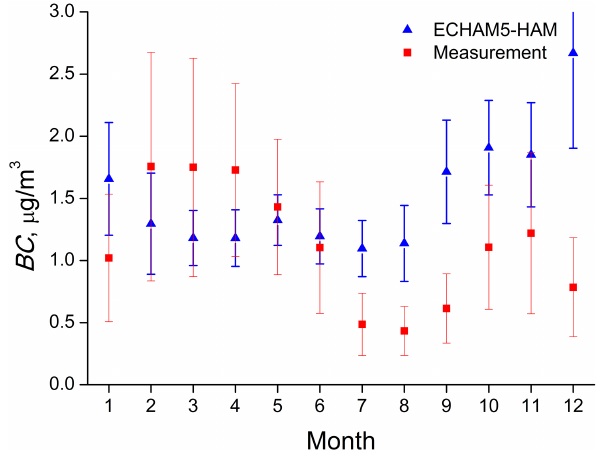
Figure 2. Surface BC concentration (in µgm − 3 ) in Mukteshwar measurements and in the MAIN_ACT simulation with GAINS emissions and aerosol cloud activation, 7-year monthly means with variability illustrated by standard deviation of daily values.